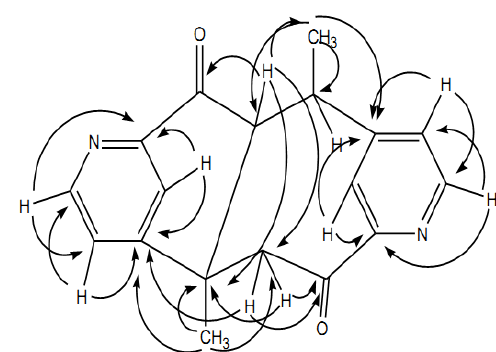
Figure 1. HMBC correlations (H ) for